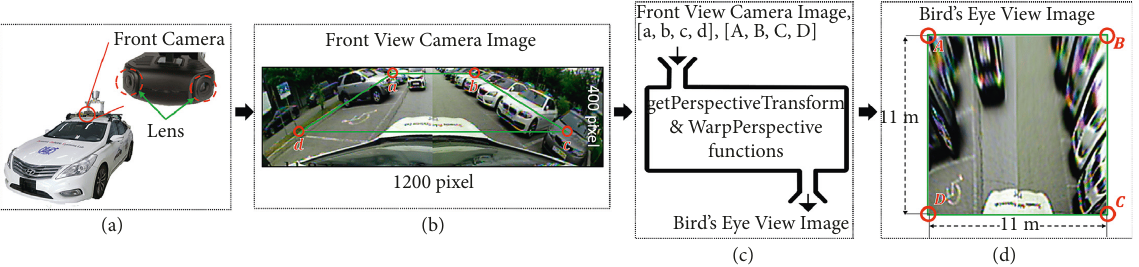
Figure 2: Process of transforming the front view camera image to bird’s eye view